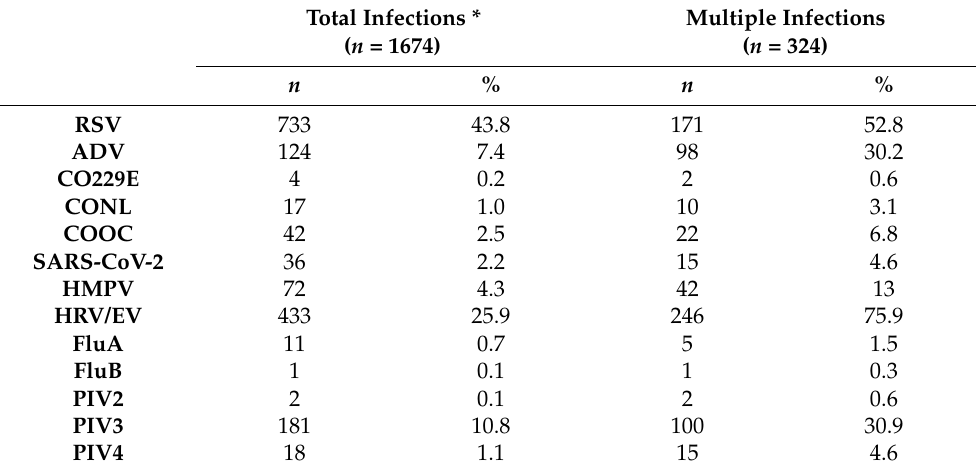
Table 1. Distribution of respiratory pathogens as total infections and their role in case of multiple